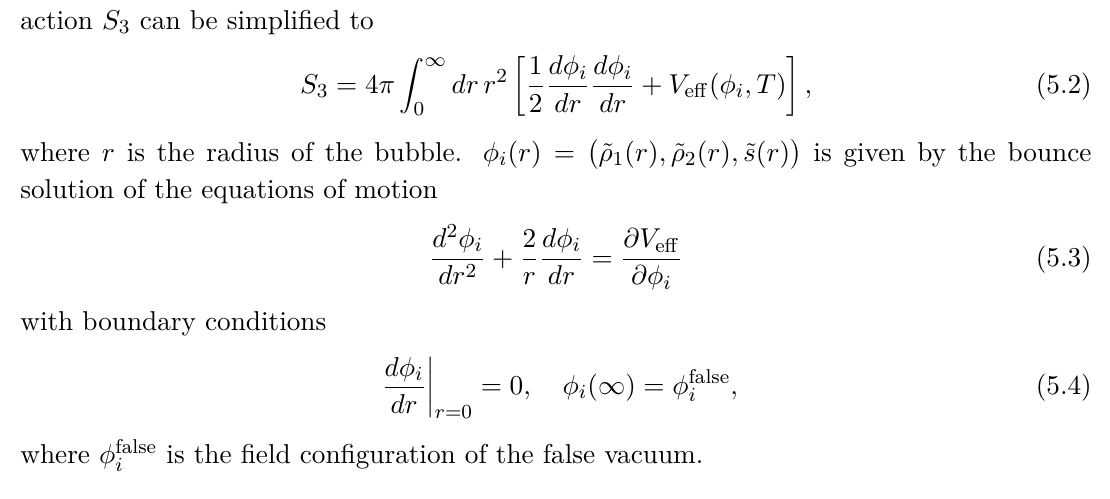
Figure 1 . Temperature evolution of the positions of the minima in the axes v 1 ( T ) , v 2 ( T ) , and v s ( T ) for BP3. The red, green, and blue lines denote three local minima. The vertical dashed lines indicate the critical, nucleation, and percolation temperatures T c , T n , and T p